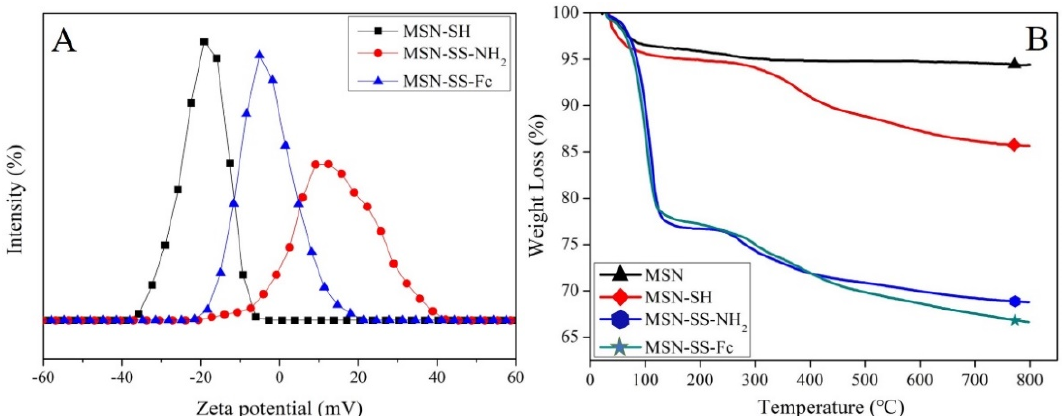
Figure 3. The zeta potentials of MSN-SH, MSN-SS-NH 2 , and MSN-SS-Fc ( A ) and the TGA analysis of MSN, MSN-SH, MSN-SS-NH 2 , and MSN-SS-Fc ( B ).